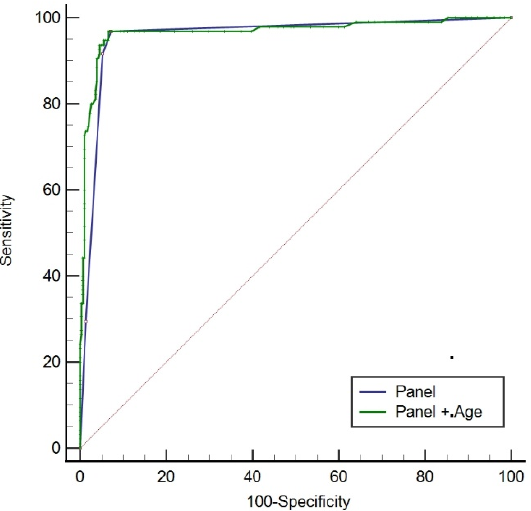
Figure 5. ROC curve of the panel (AUC = 0.958) and the panel combined with age (AUC = 0.968). Table 3. The detection performances of different models.